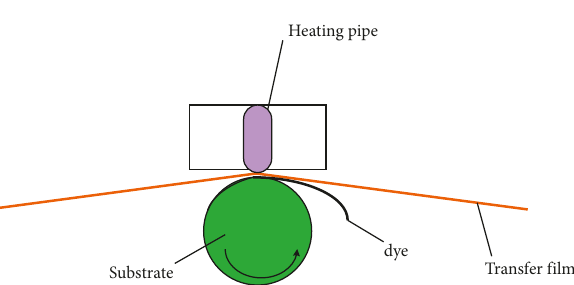
Figure 1: Common thermal transfer